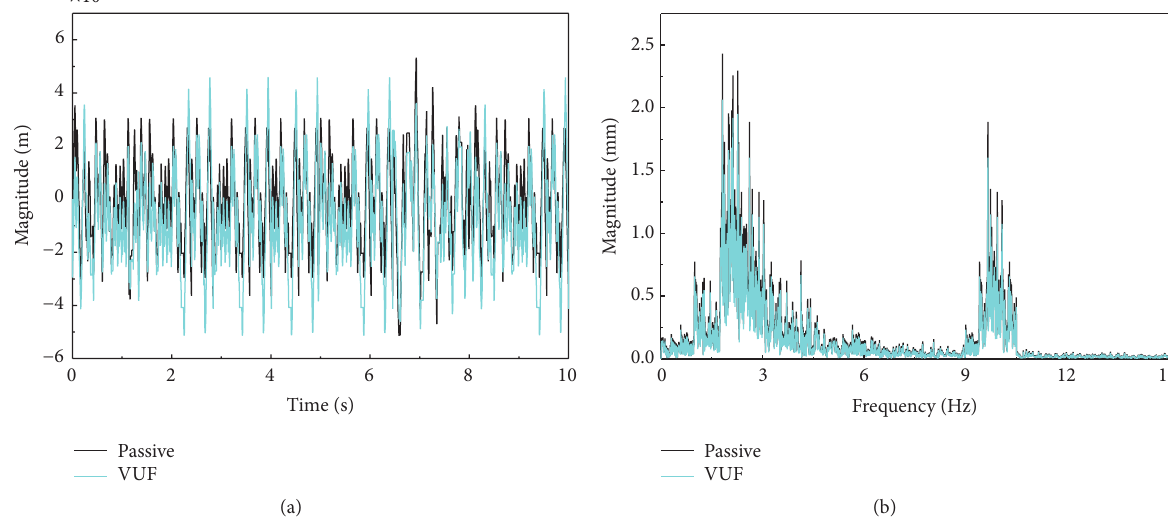
Figure 12: Experimental results of the suspension working space: (a) time domain and (b) frequency domain.